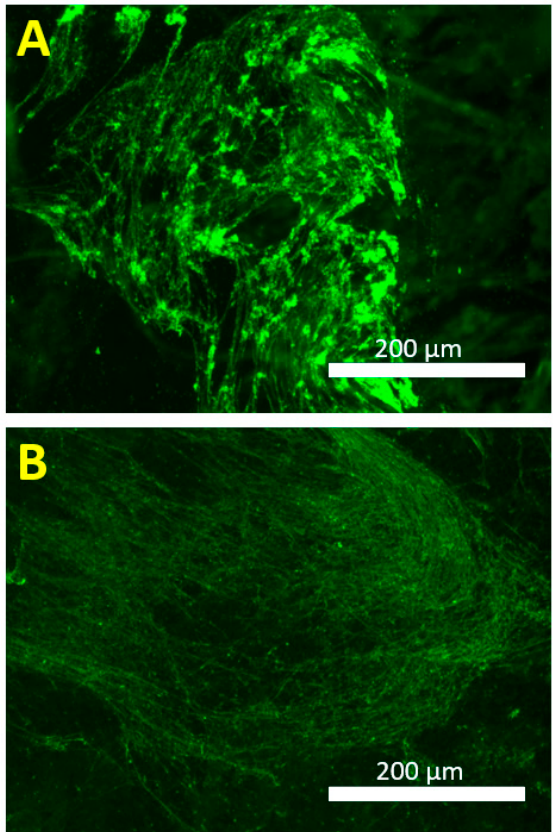
Figure 4. WGA-Alexa Fluor ® 488 fluorescent conjugate-based imaging of the 18- ( A ) and 42-h-old ( B ) S. aureus ATCC 25923 biofilm matrix. Biofilms were formed on borosilicate glass coupons and the images were taken using Invitrogen™ EVOS ® FL Imaging System.